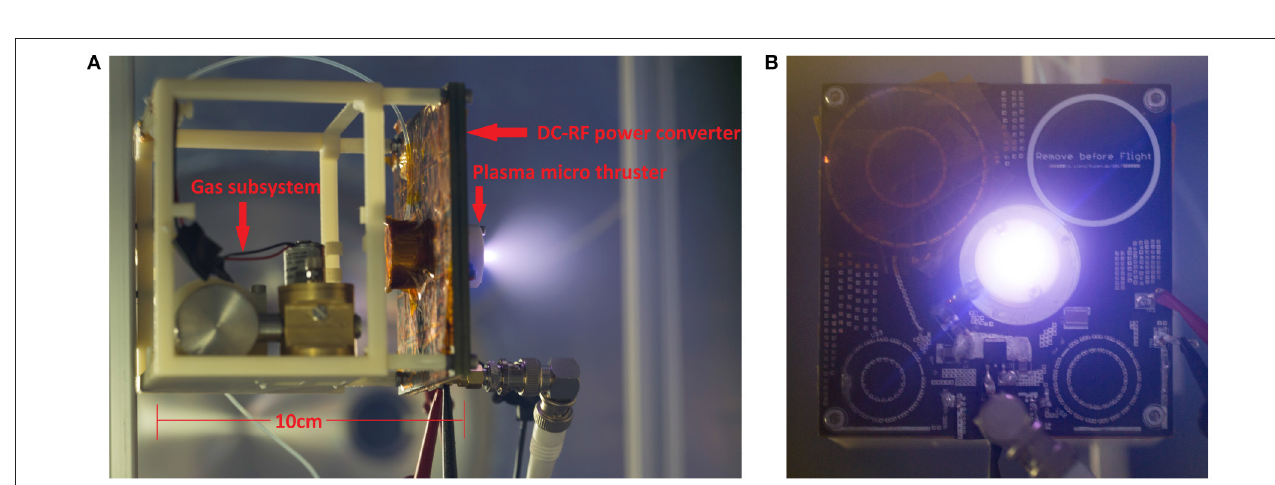
FIGURE 4 | Integration of the power delivery system and the micro-thruster. Note that as a proof of concept prototype, practical issues such as board fabrication and material use, MOSFET gate drive circuit, all RF connectors, etc are not optimized for spaceflight conditions. (A) The TinyPR, outer diameter of about 24 mm, is mounted on the PCB inverter that powers it. This working assembly is designed to serve as a single CubeSat side panel. It occupies minimal footprint as a CubeSat plasma micro thruster. (B) The back side of the integrated TinyPR and power inverter. A plastic tube can be connected to the gas subsystem as gas feed for the TinyPR. (C) The side-view of the integrated TinyPR and power inverter.